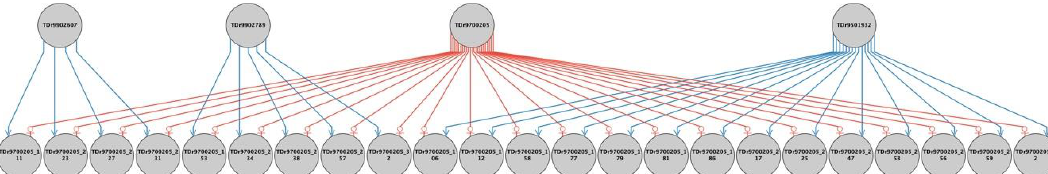
Figure 6. Pedigree reconstruction of polycross family TDr1689 based on Helium pedigree visualization . TDr9501932, TDr9902789 and TDr9902607 = male parents (blue); TDr9700205 = female parent (red).